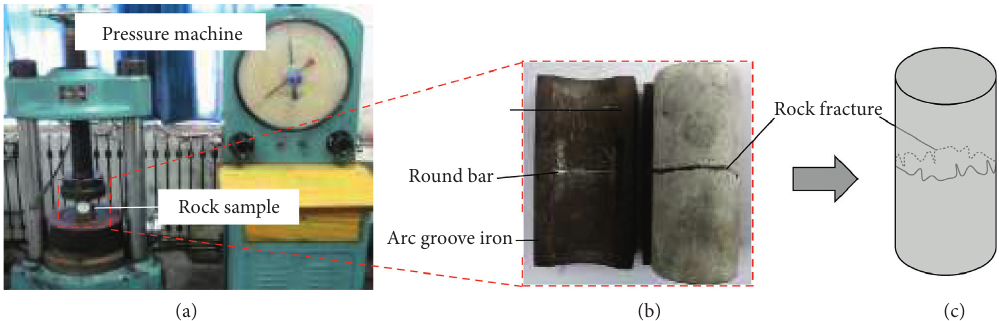
Figure 2: (a) The manufacture of rock fracture. (b) Rock fracture and splitting tool. (c) Simplified diagram.